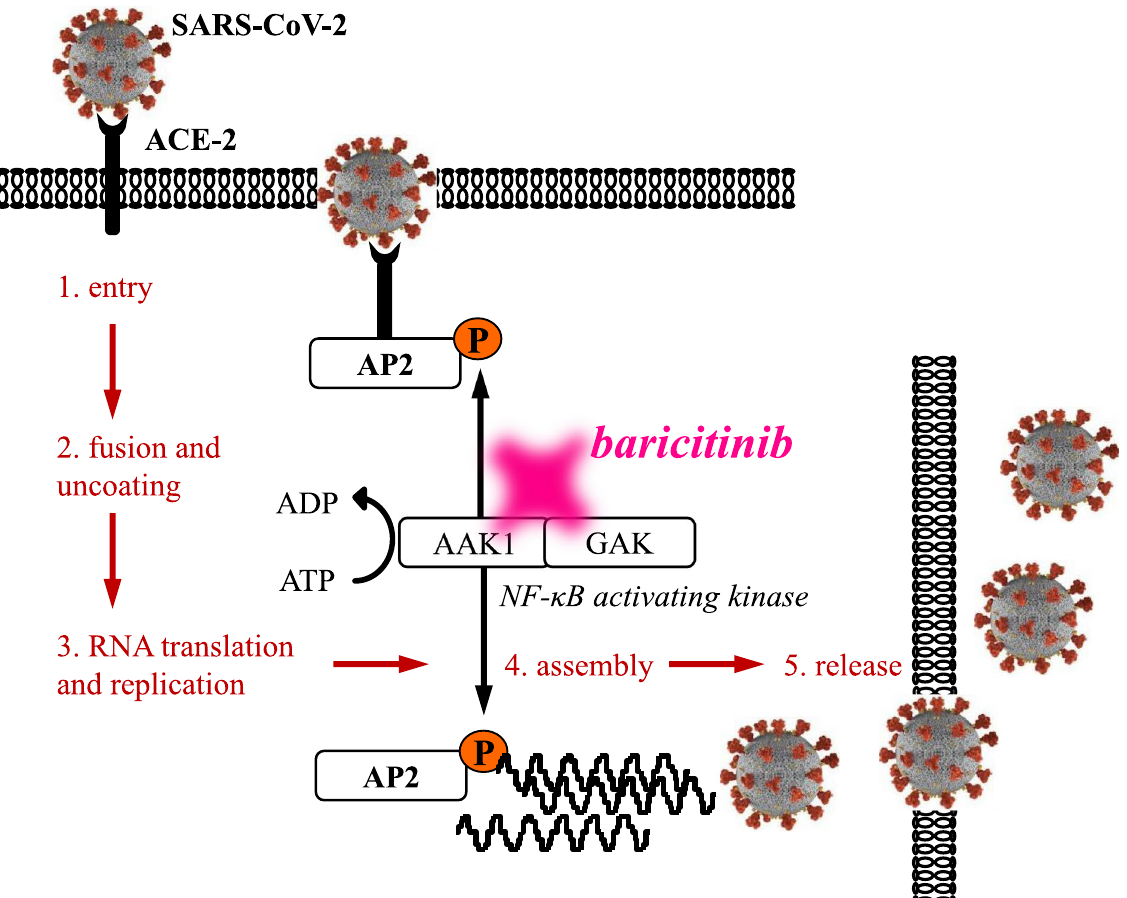
Fig. 2 Inhibition of NAK pathway by baricitinib. Baricitinib includes inhibition of viral receptor-mediated endocytosis, which involves the NF-κB activating kinase (NAK)